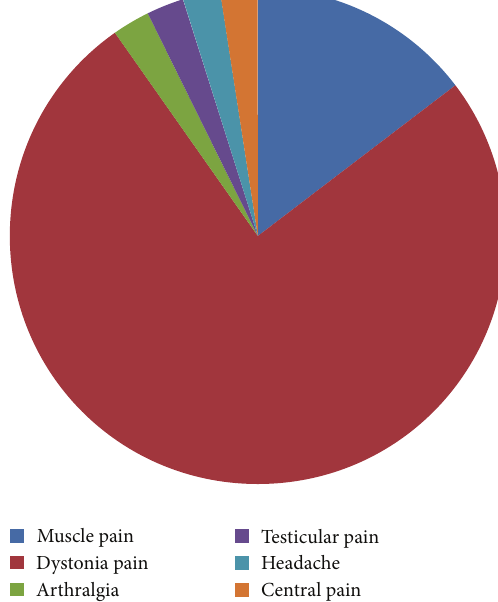
Figure 1: Category of PD-related pain.